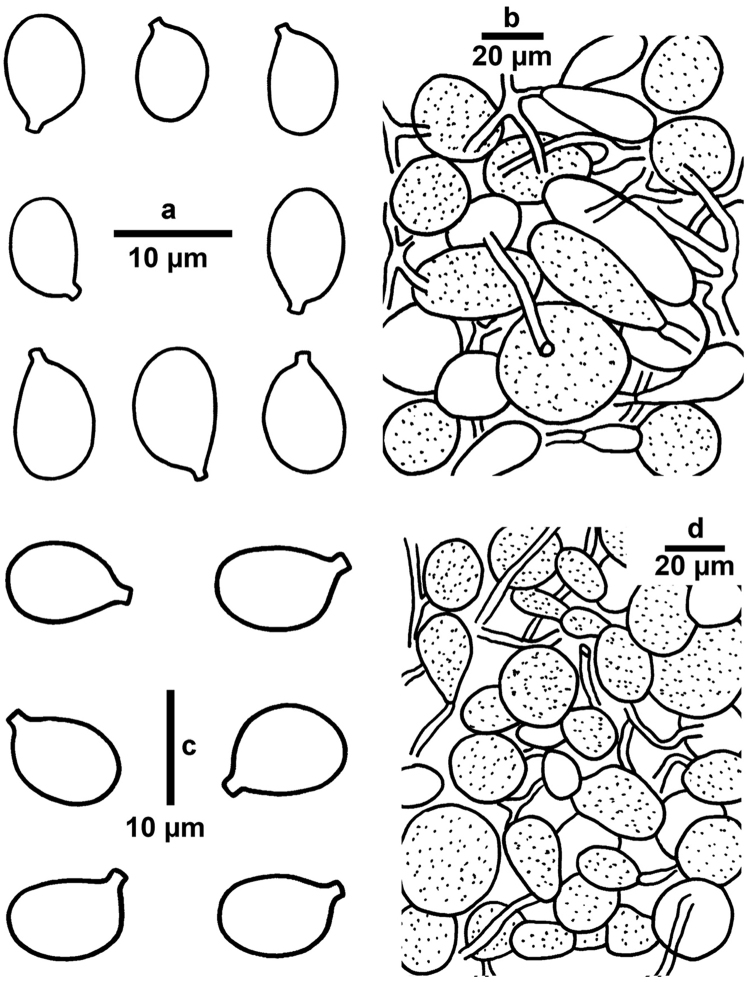
Microscopic features of Amanita species. a, bAmanitagriseoverrucosa (TM 16-1247) a Basidiospores b Elements of universal veil from pileus surface c, dAmanitavirgineoides (TM 14-413) c Basidiospores d Elements of universal veil from pileus surface.